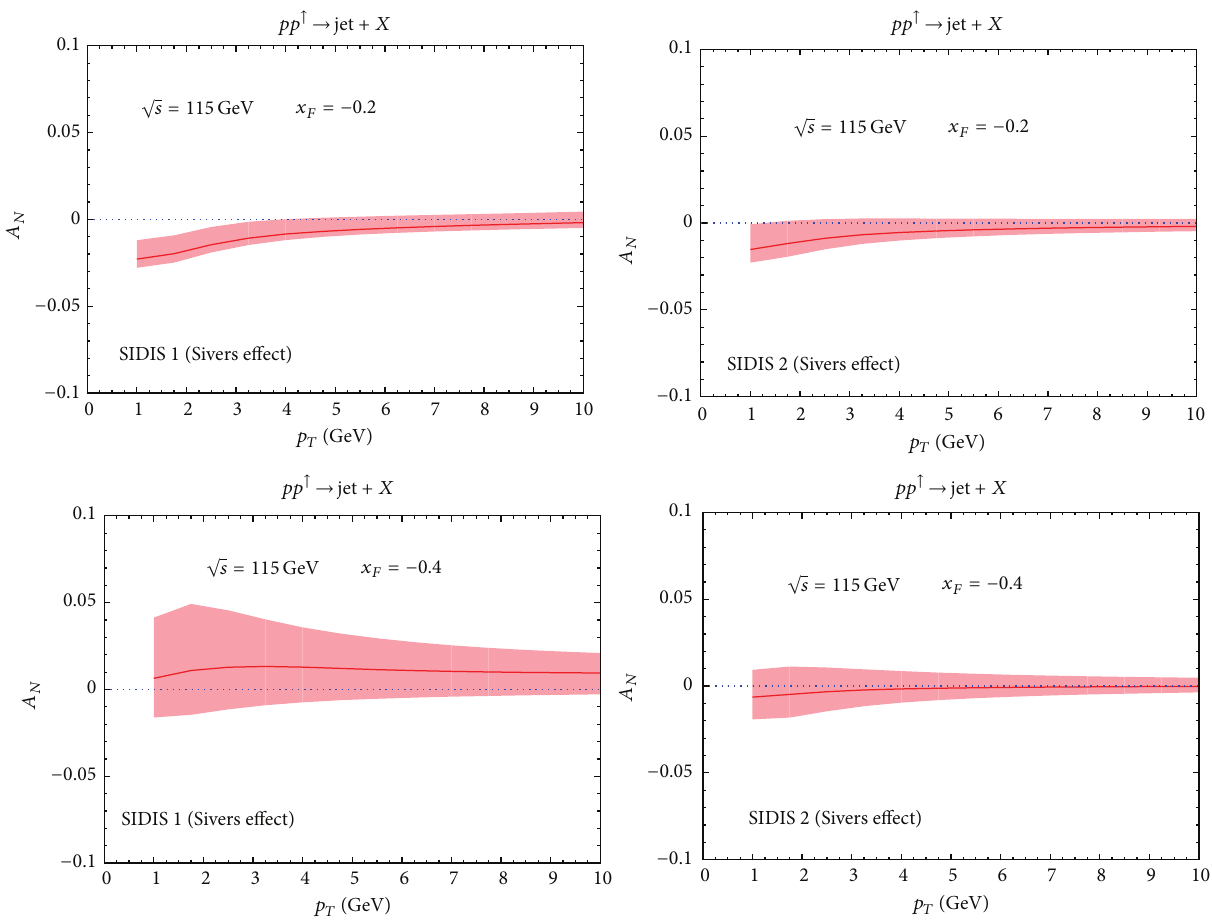
Figure7:Ourtheoreticalestimatesfor 𝐴 𝑁 versus 𝑥 𝐹 at √𝑠 = 115 GeV, 𝑥 𝐹 = − 0 . 2(upperplots),and 𝑥 𝐹 = − 0 . 4(lowerplots)forinclusivesingle jet production in 𝑝𝑝 ↑ → jet 𝑋 processes, computed according to (6) and (7) of the text. Only the Sivers effect contributes. The computation is performed adopting the Sivers functions of [20] (SIDIS 1, left panels) and of [21] (SIDIS 2, right panels). The overall statistical uncertainty band, also shown, is obtained following the procedure described in Appendix A of